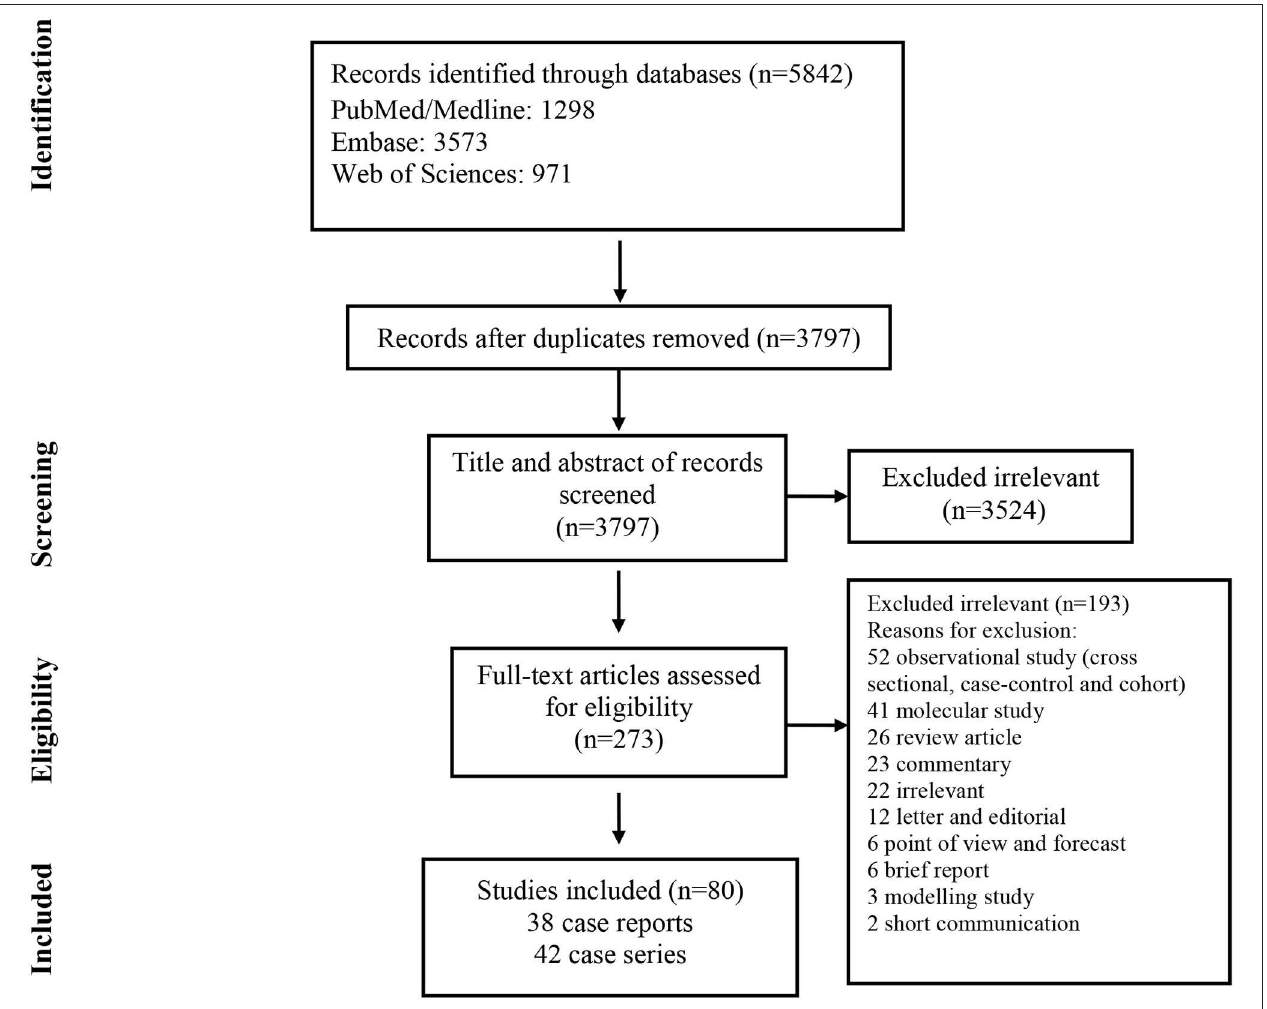
FIGURE 1 | Flow chart of study selection for inclusion in the systematic